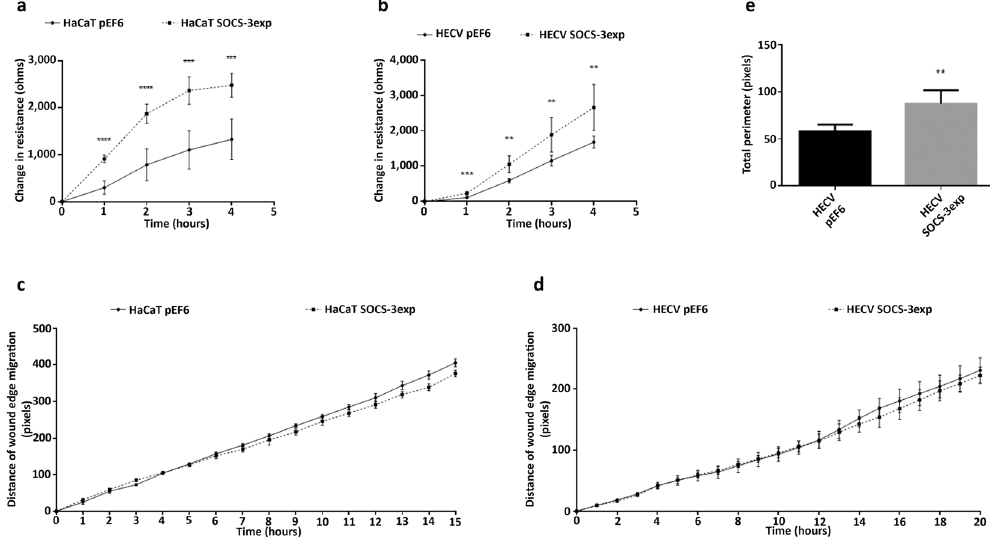
Figure 5. Impact of SOCS-3 over-expression on cellular migration and tubule formation. Cellular migration was assessed using an ECIS model in ( a ) HaCaT and ( b ) HECV cells following SOCS-3 over-expression. Mean change in resistance following monolayer wounding was detected by the ECIS system and was used to quantify cell migration. Cellular migration was also explored using a conventional scratch wound assay, monitored by the EVOS system, in ( c ) HaCaT and ( d ) HECV cells following SOCS-3 over-expression. Angiogenic potential was assessed following SOCS-3 over-expression in HECV cells using a Matrigel tubule formation assay ( e ). Data shown is representative of a minimum of three repeats, error bars represent standard deviation (a/b/e) and standard error of the mean (c/d), ** represents p < 0.01, *** represents p < 0.001 and **** represents p <